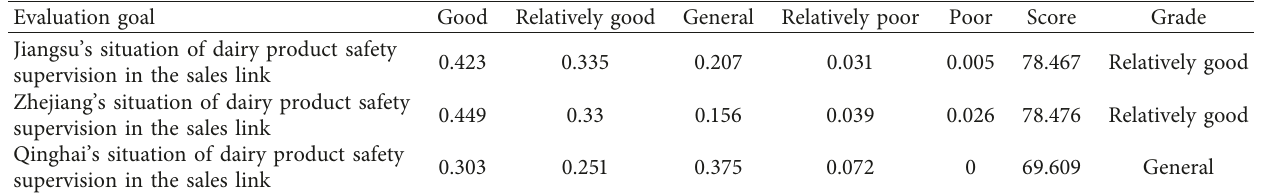
Table 11: Scores of the safety supervision of dairy products in the sales link for three offline provinces 1